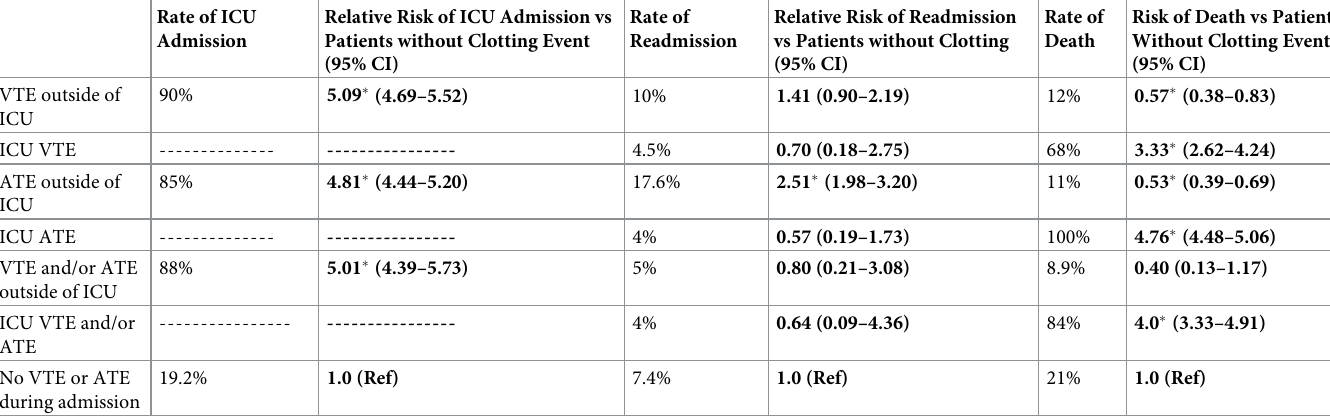
Table 3. Rates and risk ratios of ICU admission, readmission to the hospital, and death among COVID-19 patients with clotting events. Rate of ICU